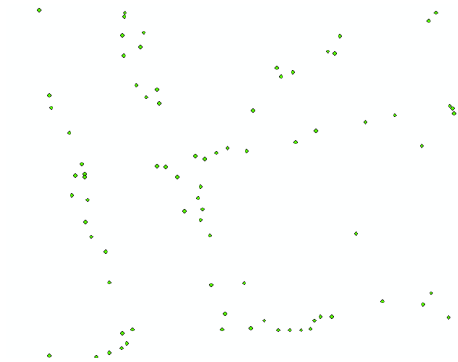
Figure 4 . Geographical names to be evaluated(partly)